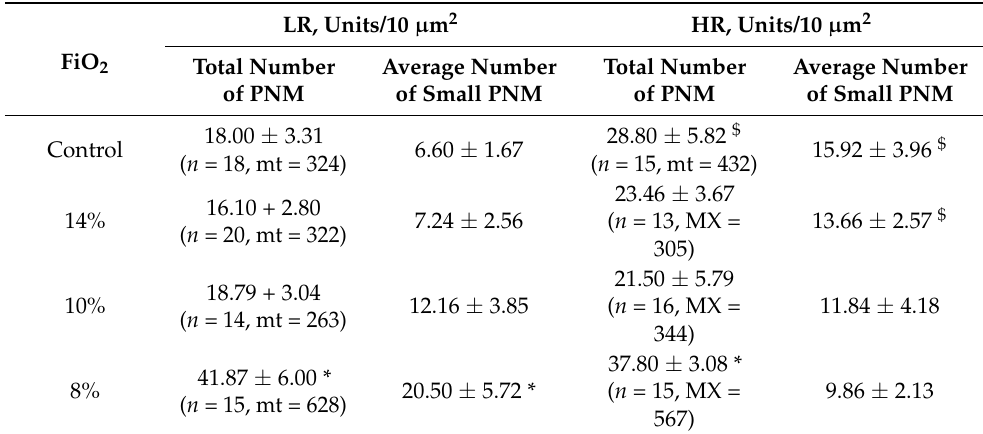
Table 5. Morphometric characteristics of PNM in the myocardium of HR and LR rats after a single exposure to different HBH regimens. LR, Units/10 µ m 2 HR, Units/10 µ m 2 FiO 2 Total Number Average Number Total Number Average Number of PNM of Small PNM of PNM of Small PNM 18.00 ± 3.31 28.80 ± 5.82 Control 6.60 ± 1.67 ( n = 18, mt = 324)